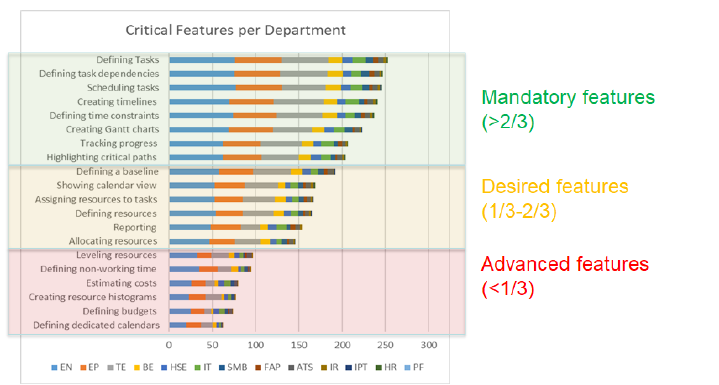
Figure 3. MS Project Survey - Features per Department